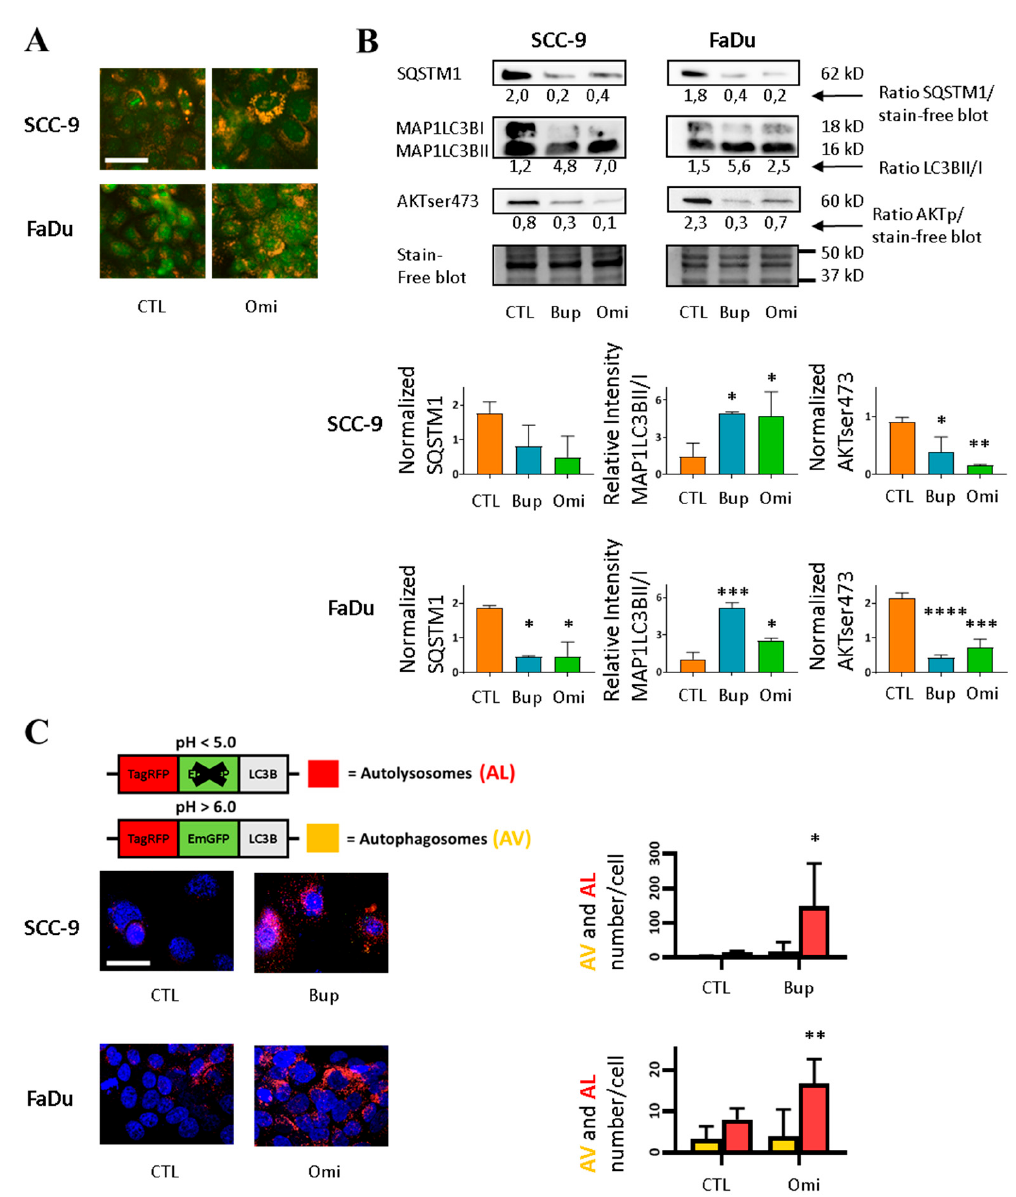
Figure 1. PI3Ki induce autophagy flux in head and neck squamous cell carcinoma (HNSCC) cell lines. ( A ) PI3Ki increase the number of acidic vacuoles. HNSCC cell lines SCC-9 and FaDu were incubated with vehicle dimethyl sulfoxide (DMSO (CTL)) or 1 nM Omi for one day and stained for 15 min. with acridine orange. Nuclei stain green and acidic organelles stain orange. Images are representative of three independent experiments. Scale bar = 50 µ m. ( B ) Western blot analysis of autophagy markers and AKTser473 phosphorylation. Top: Autophagy flux is indicated by SQSTM1 degradation and MAP1LC3B conversion, and inhibition of phosphatidylinositol 3-kinase (PI3K) signaling pathway is indicated by decreased AKTser473 phosphorylation. Equal loading of proteins is shown with a stain-free blot. SCC-9 and FaDu were incubated for three days with vehicle, 0.5 µ M Bup or 1 nM